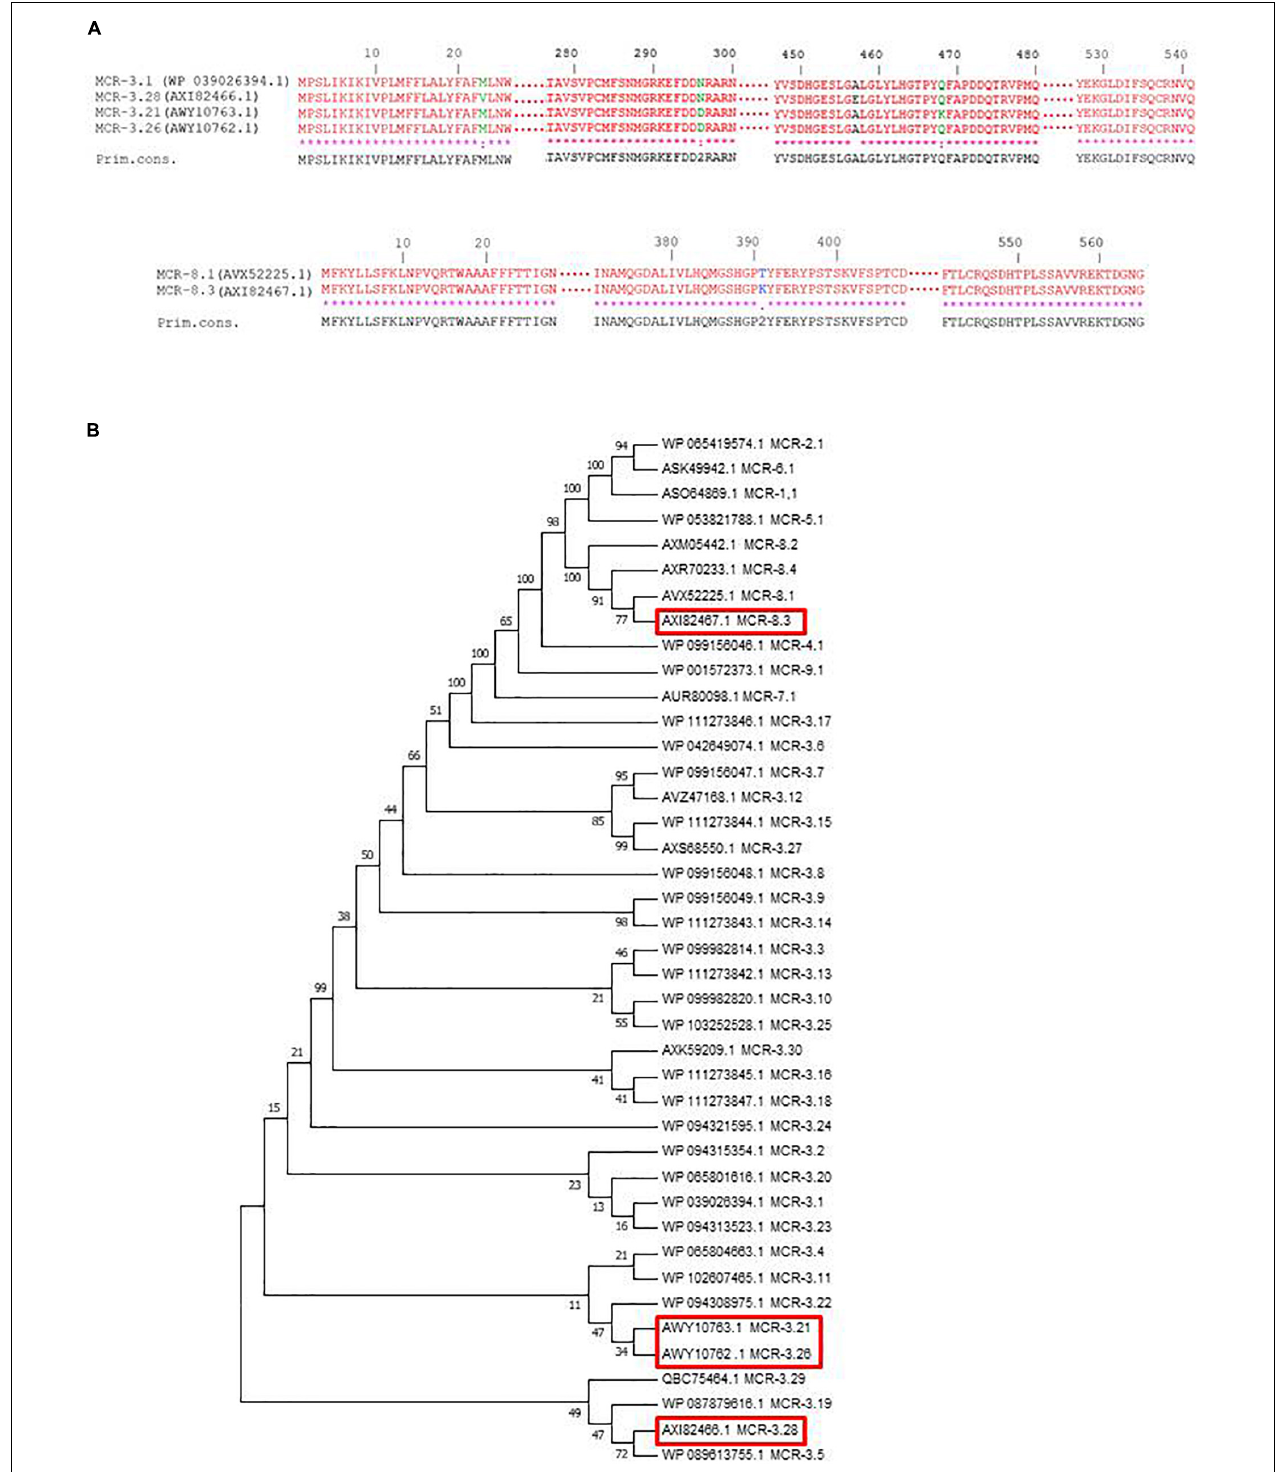
FIGURE 1 | (A) Amino acid sequence alignments of the new MCR-3 and MCR-8 variants using Clustal W on NPS@ website. (B) Phylogenetic tree of MCR variants, including MCR-3 and MCR-8 variants. Sequences were aligned using MUSCLE and phylogenetic interferences were obtained using the neighbor-joining method within the MEGA 7 software. Numbers at the nodes are percentages of bootstrap values obtained by repeating the analysis 500 times to generate a majority consensus tree. Evolutionary distances were computed using the Poisson correction method and are expressed in units of the number of amino acid substitutions per